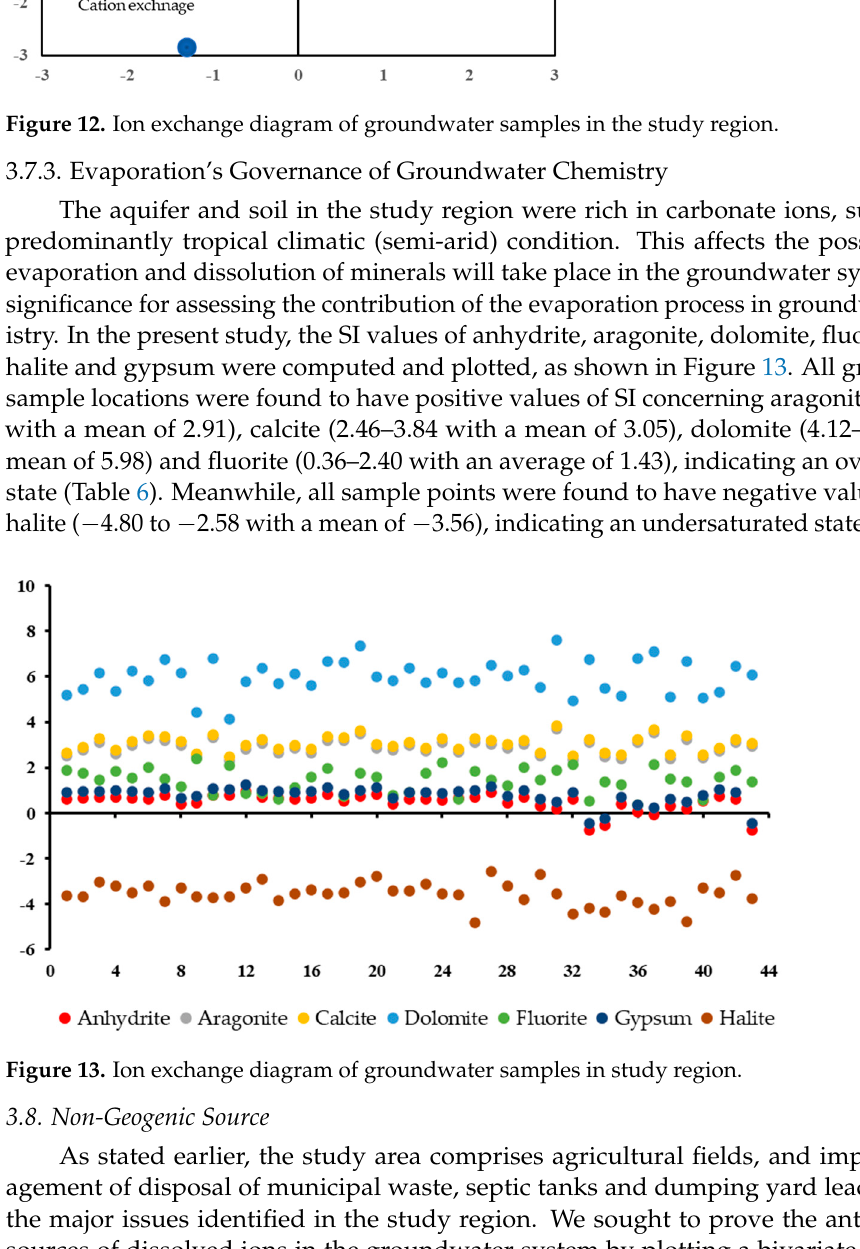
Figure 13. Ion exchange diagram of groundwater samples in study region.